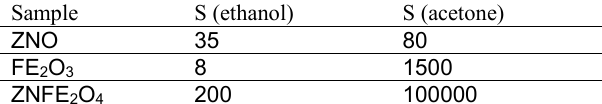
Table 2. Gas sensitivity values of S samples of ZnO, Fe2O3, ZnFe2O4 to ethanol and acetone vapors of 1000 ppm